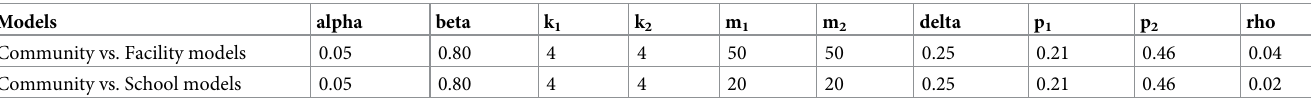
Table 3. Power and sample size for the comparison of service delivery model.